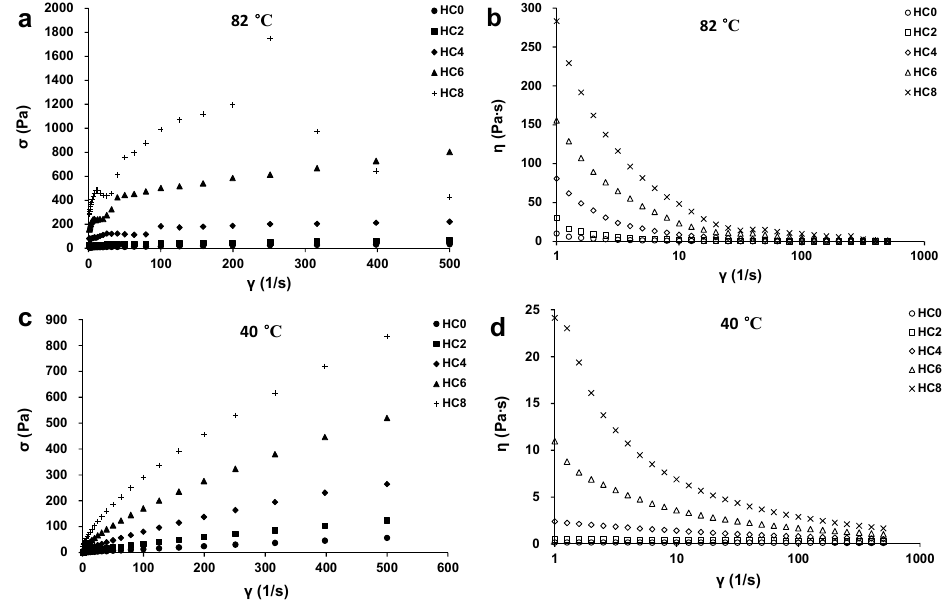
Figure 4. Shear stress and viscosity curves of HPMC/CL blends at 82 °C ( a , b ) and 40 °C ( c , d ). According to fluid Equations (1) or (2) in Section 2.3, the shear stress–shear rate re- sults were fitted, and the n , K , σ y , and r 2 values of the HPMC with different CL contents at different temperatures are calculated and displayed in Table 2. At 82 °C, HC8 did not conform to these monotonous functions, since a negative slope appeared; a negative slope in steady flow curves is an indication of instabilities, which are due to shear banding, wall slip, etc. [29]. Equation (2) can be used to fit the results of all the other samples at 82 °C, and the fitting results were relatively good based on the value of r 2 , meaning that they